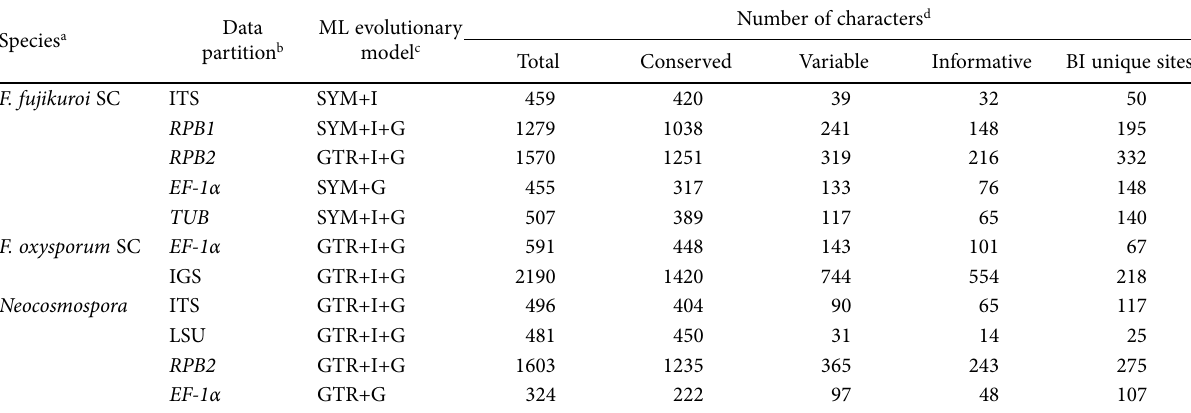
Table 3. Characteristics of the data partitions used for phylogenetic analyses in this study.